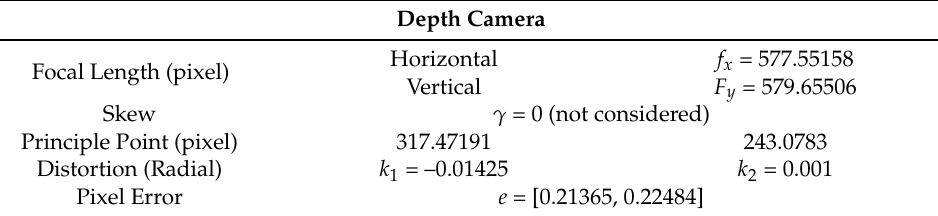
Table 1. The depth camera’s intrinsic